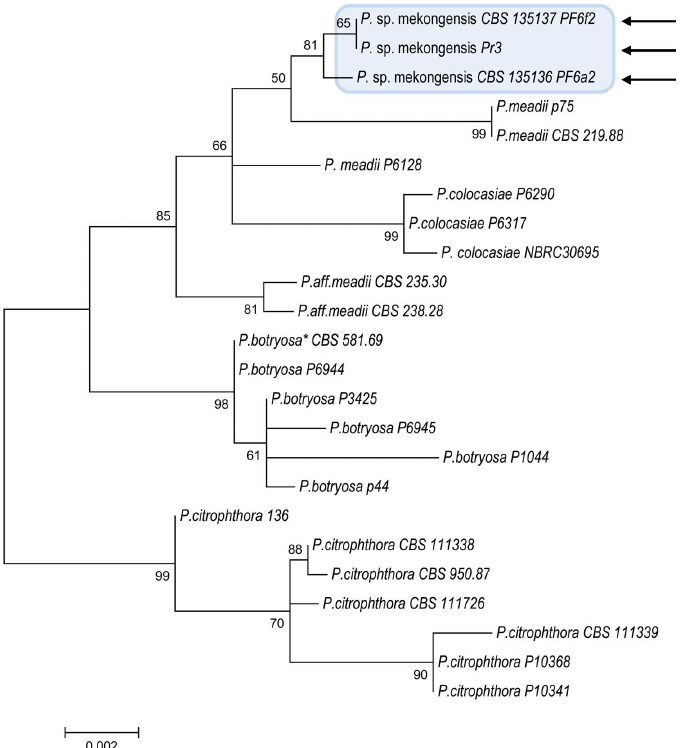
Fig 5. Molecular phylogenetic analysis of the combined data set ITS and COI among isolates Pf6f2, Pr3 and Pf6a2 of P . sp. mekongensis (indicated by arrows) within Phytophthora major Clade 2 by Maximum Likelihood method, based on the Tamura-Nei model. The percentage of trees in which the associated taxa clusteredtogether is shownnext to the branches. Initial trees for the heuristicsearch were obtained by applyingthe Neighbor-Joining method to a matrix of pairwisedistances estimated using the Maximum Composite Likelihood(MCL) approach.The tree was drawn to scale, with branch lengths measuredin the numberof substitutionsper site. Bootstrap values were obtainedfrom 1000replications. Asterisk ( * ) indicatesthe ex-type